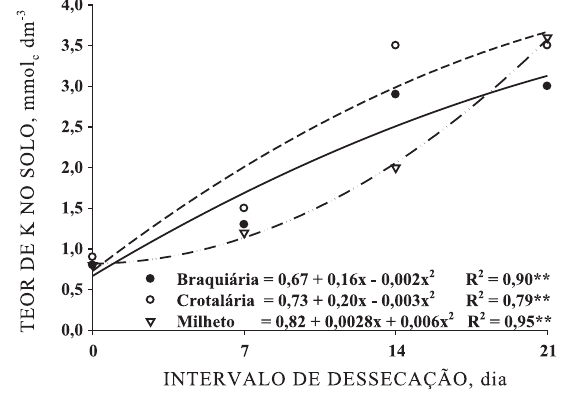
Figura 2. Teor de potássio no solo, em função do intervalo de dessecação, em diferentes espécies de plantas